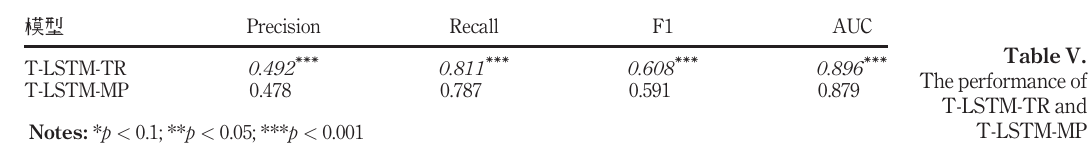
Table V. The performance